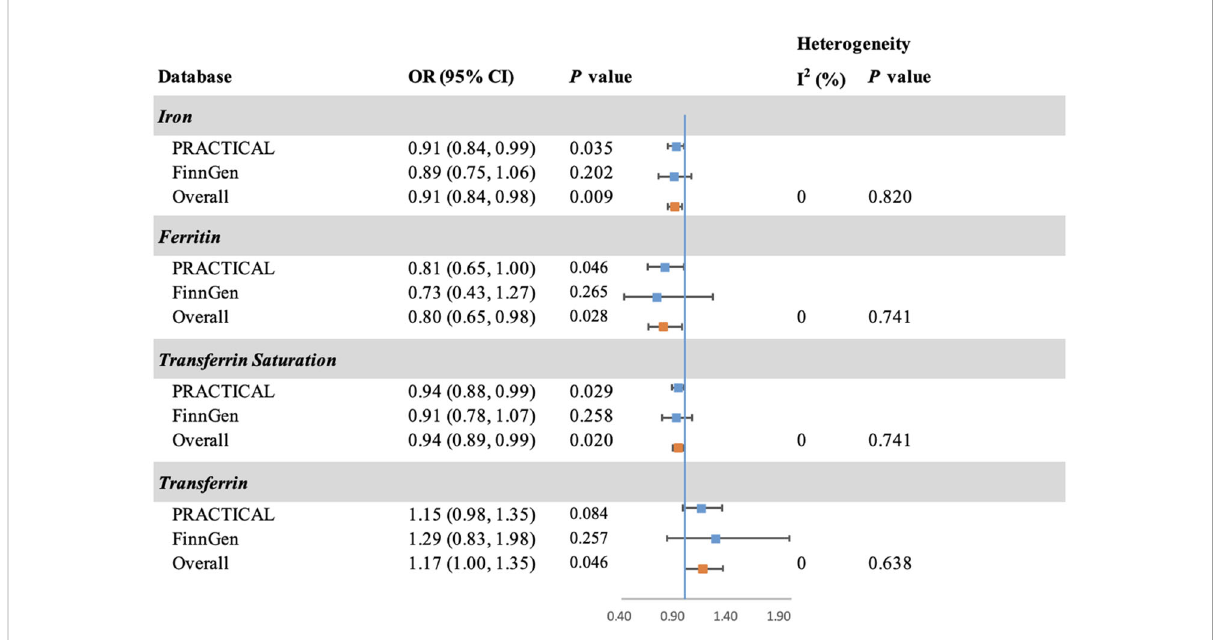
FIGURE 3 Forest plot of the MR estimates of iron status on prostate cancer in PRACTICAL and FinnGen. The overall odds ratios with 95% CIs were generated using random-effects model. Abbreviations: PRACTICAL, Prostate Cancer Association Group to Investigate Cancer Associated Alterations in the Genome; CI, con fi dence